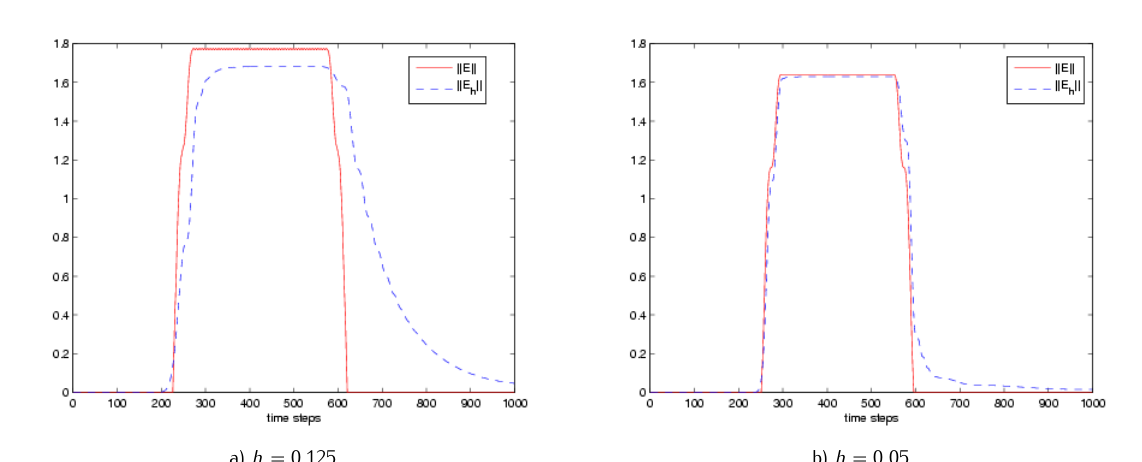
-norms for kEk and kE h k on different meshes with mesh sizes h = 0 . 125 and 2 -norms during time T = (0 , 20) in Ω . Here, the horizontal axis denotes the number of 2 FEM